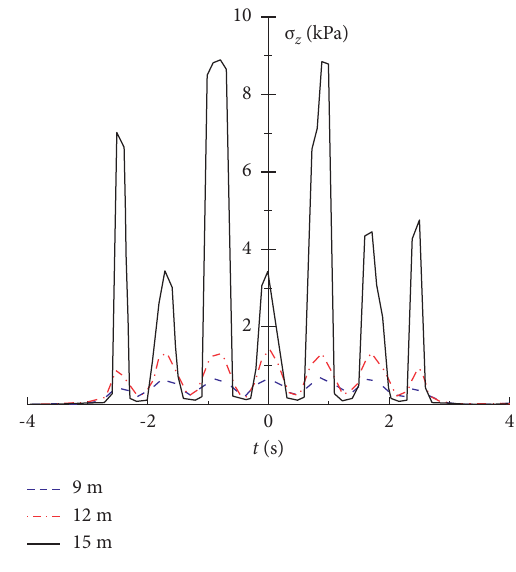
Figure 8: σ z of soils with different depths.